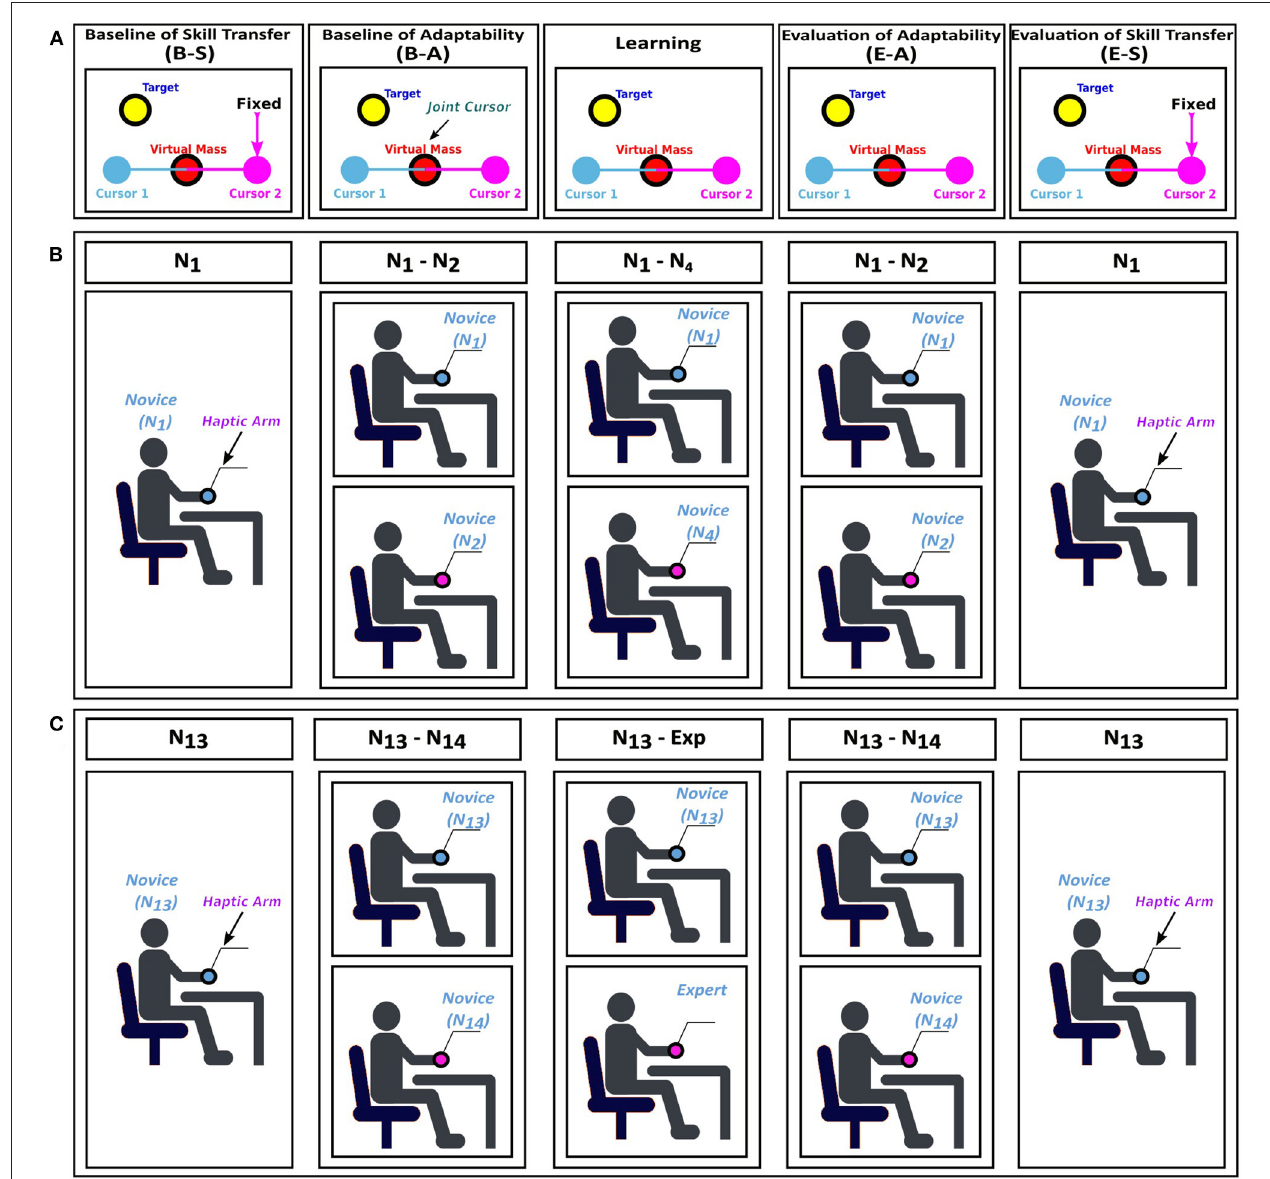
FIGURE 1 | Experimental protocol. (A) The structure of the virtual tool and the experimental phases for the Novice-Novice ( N-N ) and Novice-Expert ( N-E ) groups: Baseline of Skill Transfer (B-S), Baseline of Adaptability (B-A), Learning, Evaluation of Adaptability (E-A), and Evaluation of Skill Transfer (E-S). (B) N-N group; the Learning phase was performed with a new novice participant (here, N1 and N4 ). (C) N-E group; the Learning phase was performed with an expert (here, N13 and Exp